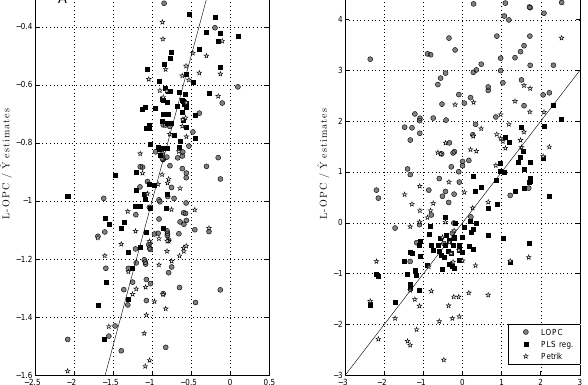
Figure 4. Scatter graph of the relations of NBSS slopes (a) and intercepts (b) estimated by the WP2/Zs vs. the raw LOPC (grey circles), and after the PLS (partial least square) regression was per- formed on the LOPC ( ˆ Y , black plain square). In addition, the result of estimating NBSS parameters of LOPC data corrected using the method of Petrik et al. (2013) are added (grey stars). The x = y line is added to each plot.